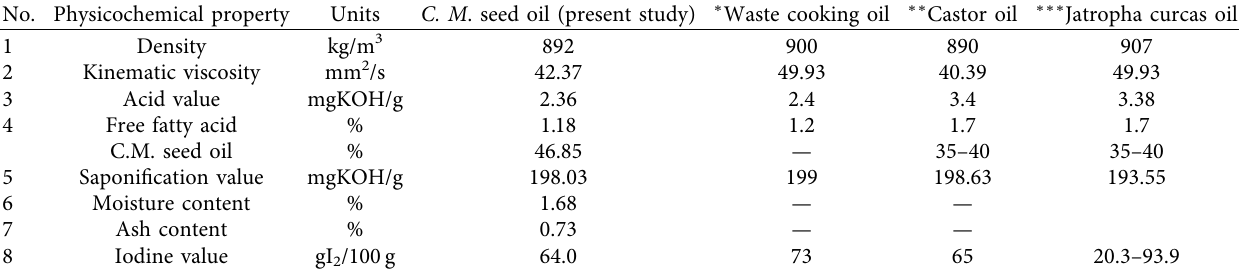
Table 2: Summary of physicochemical properties of C. M. seed oil with another feedstock [22].